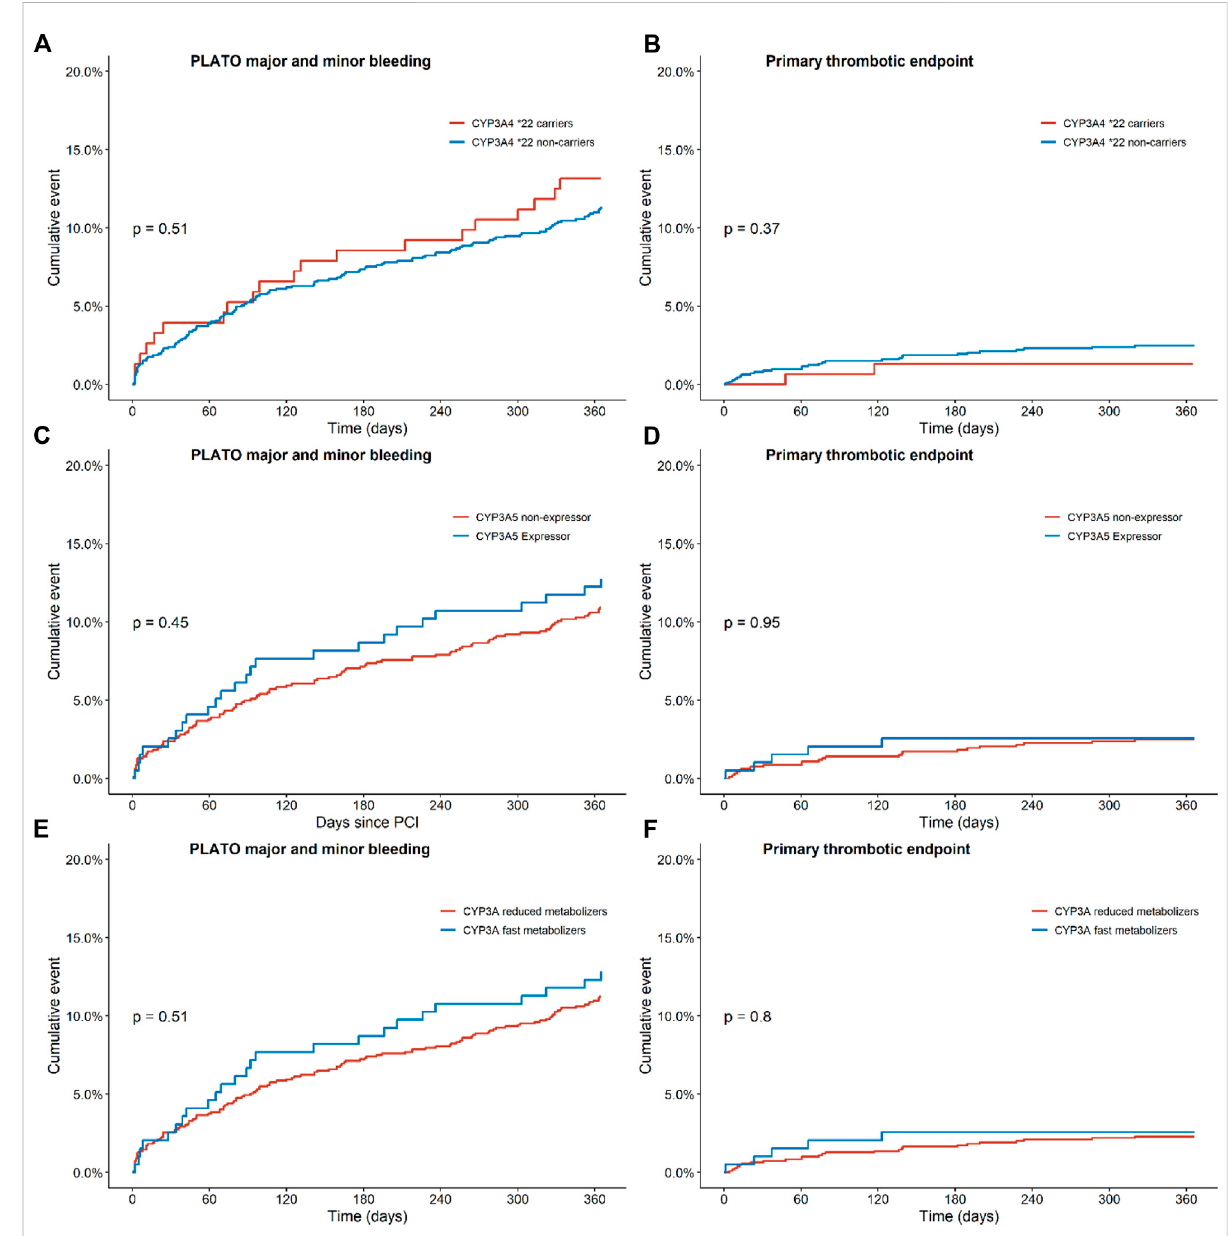
FIGURE 2 Endpoints of ticagrelor treated patients with regards to the combined thrombotic and bleeding endpoint for CYP3A, CYP3A4 and CYP3A5 status. Kaplan-Meier curves for (A) the combined bleeding endpoint, de fi ned as PLATO major and minor bleeding in CYP3A4*22 carriers versus non-carriers,for (B) thecombinedthromboticendpoint,de fi nedascardiovasculardeath,myocardialinfarction,de fi nitestentthrombosis,and strokeinCYP3A4*;22carriers versus noncarriers,for (C) thecombinedbleedingendpointinCYP3A5expressors versus non-expressors,for (D) the combined thrombotic endpoint in CYP3A5 expressors versus non-expressors, for (E) the combined bleeding endpoint in CYP3A fast metabolizers versus reduced metabolizers and for (F) the combined thrombotic endpoint in CYP3A fast metabolizers versus reduced